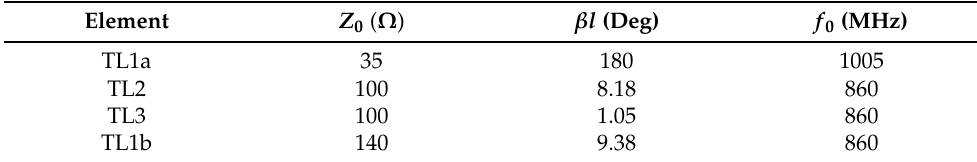
Table 1. Elements of the filters from Figures 6 and 8.